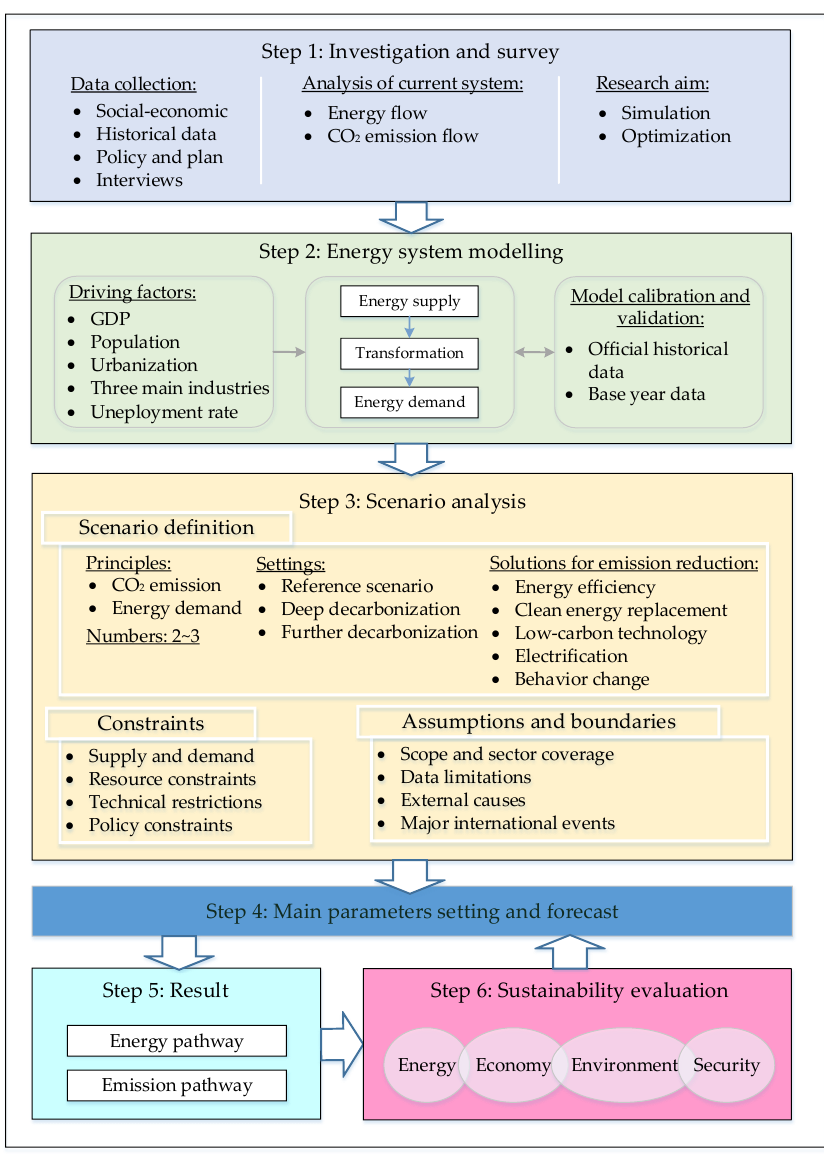
Figure 1. The procedures of energy system decarbonization pathways (simulation).